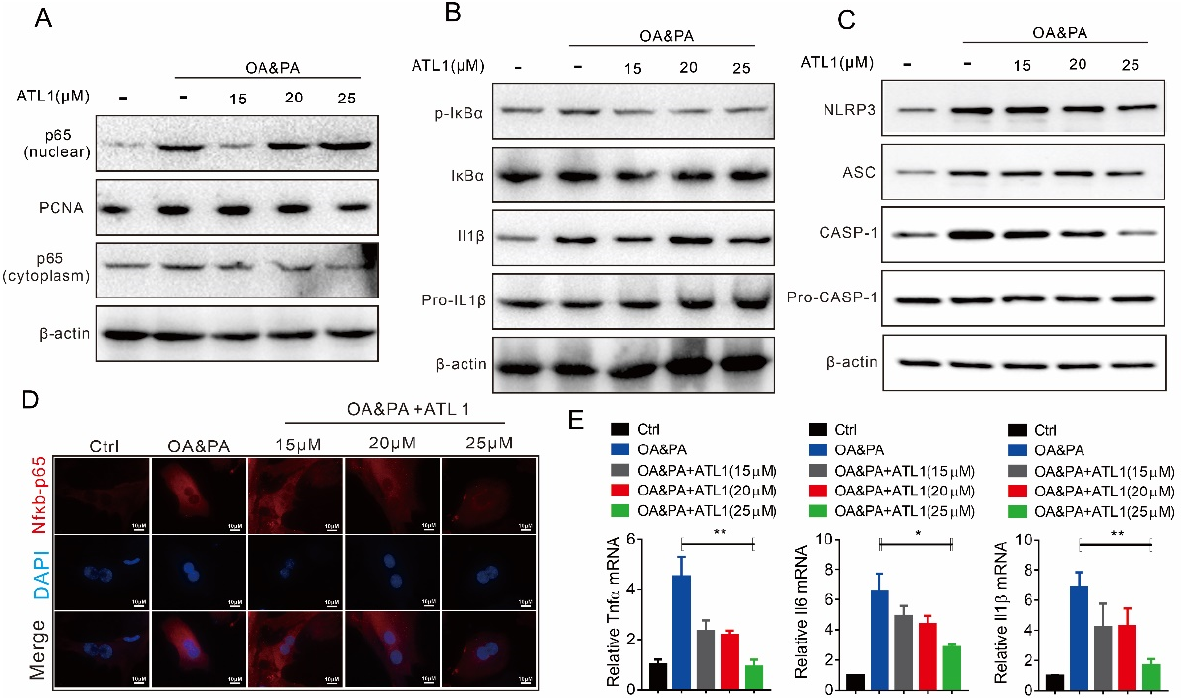
Figure 2. ATL I treatment suppressed OA&PA-induced NLRP3 inflammasome and inflammatory response in vitro. ( A ) Western blot indicated that ATL I treatment significantly decreased the OA&PA-induced p65 levels in the nuclei of MPHs. ( B , C ) ATL I treatment significantly decreased the OA&PA-induced expression of proteins related to NLRP3 inflammasome formation. ( D ) Immunofluorescence data indicated a decreased level of Nf κ B-p65 levels in OA&PA-treated MPHs after ATL I treatment. ( E ) ATL I treatment effectively reversed the mRNA levels of inflammatory genes in OA&PA cultured MPHs after ATL I treatment. Results are shown as mean ± SEM (n ≥ 3). * p < 0.05, ** p < 0.01 versus the OA&PA group.